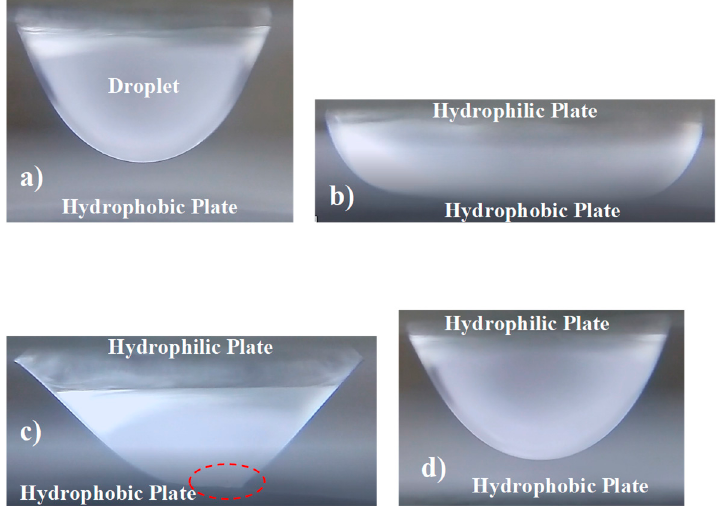
Figure 6. Images of water droplets squeezed in between hydrophilic and hydrophobic plates: ( a ) prior squeezing, ( b ) squeezed, ( c ) hydrophilic plate is lifted (red circle shows droplet pinning section on hydrophobic surface), and ( d ) hydrophilic plate is lifted. No pinch-off droplet fluid is observed on hydrophobic plate.